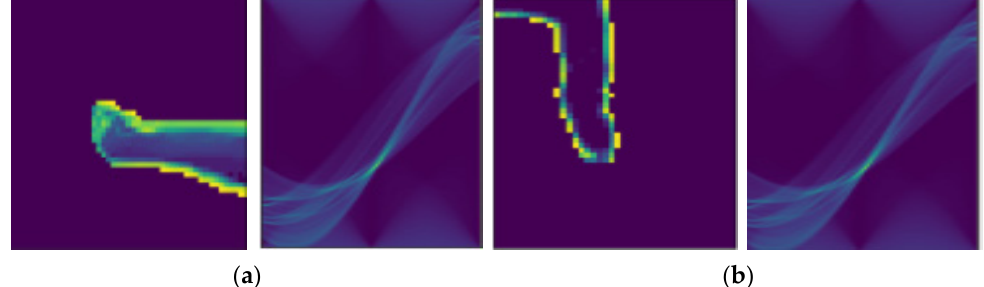
Figure 8. Radon transforms of a silhouette from the VIRAT Video dataset, including ( a ) a window